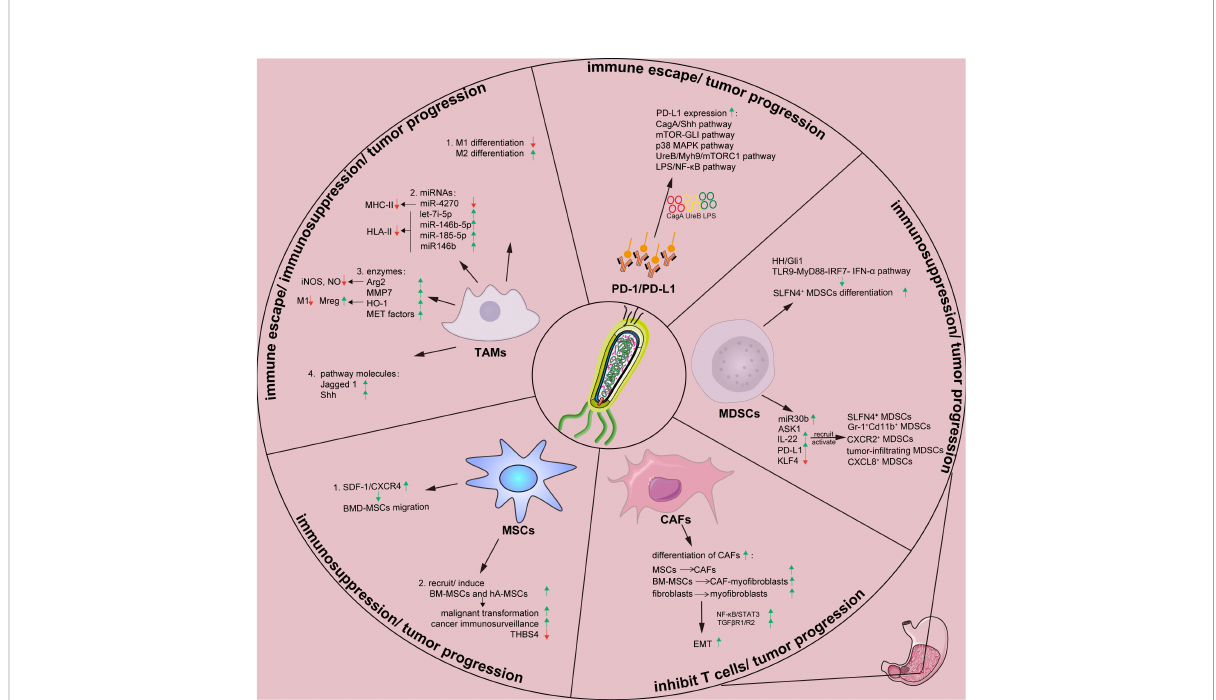
FIGURE 1 Effects of H. pylori on tumor stromal cells and tumor-related proteins in gastric tumor immune microenvironment. Arg, arginase; ASK1, apoptosis signal-regulating kinase 1; BM-MSC, Bone marrow-derived mesenchymal stem cells; CAF, cancer-associated fi broblast; Cag A, cytotoxin-associated gene A; CXCL8, chemokine (C-X-C motif) ligand 8; EMT, epithelial-mesenchymal transition; hA-MSC, human adipose- derived mesenchymal stem cells; HH, Hedgehog; HO-1, heme oxygenase-1; H.pylori , Helicobacter pylori ; IL-22, Interleukin-22; IRF, interferon regulatory factor; IFN, interferon; KLF4, Krüppel-like factor 4; LPS, lipopolysaccharide; MAPK, mitogen-activated protein kinases; MDSCs, myeloid-derived suppressor cells; MET, mesenchymal-epithelial transition; MHC-II, major histocompatibility complex class II; MMP, matrix metalloproteinase; mTOR, mammalian target of rapamycin; Myh9, myosin heavy chain 9; NF- k B, nuclear factor kappa B; miR, microRNA; MSCs, mesenchymal stem cells; PD-1, programmed death 1; PD-L1, programmed death-ligand 1; PI3K-AKT, phosphatidylinositol 3 kinase-protein kinase B; ROS, reactive oxygen species; SDF, stromal-derived factor; Shh, Sonic hedgehog; SLFN4, Schlafen 4; STAT3, signal transducer and activator of transcription 3; TAMs, tumor-associated macrophages; TGF b , transforming growth factor b ; TLR, Toll-like receptor; Ure, urease; Vac A, vacuolating cytotoxin